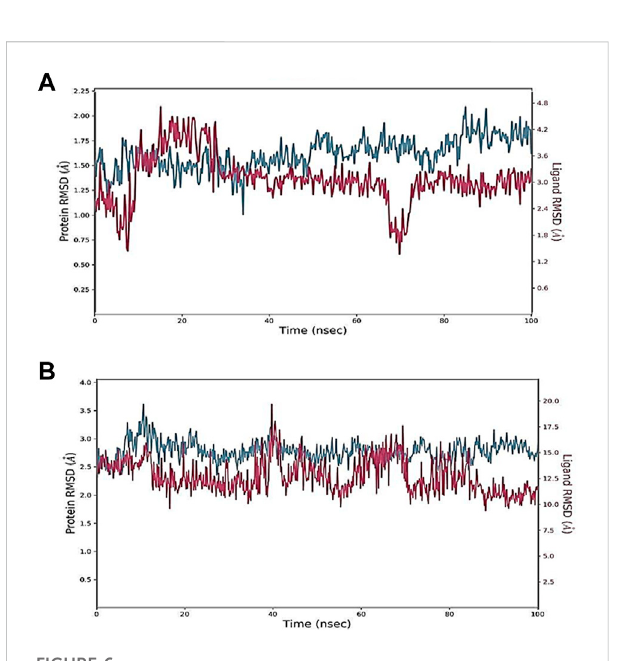
FIGURE 6 Root mean square deviation (RMSD) of docked complexes: (A) Oleanolic acid-MMP9 and (B) kaempferol-PPARG.